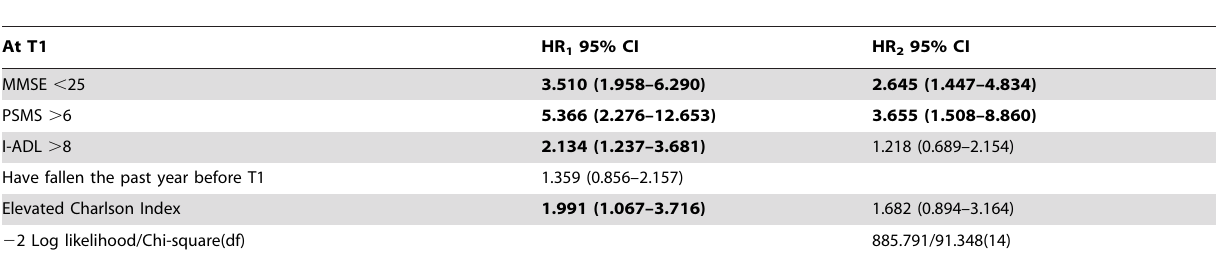
Table 4. Hazard ratio associations before nursing home admission during the follow-up year (N =463).